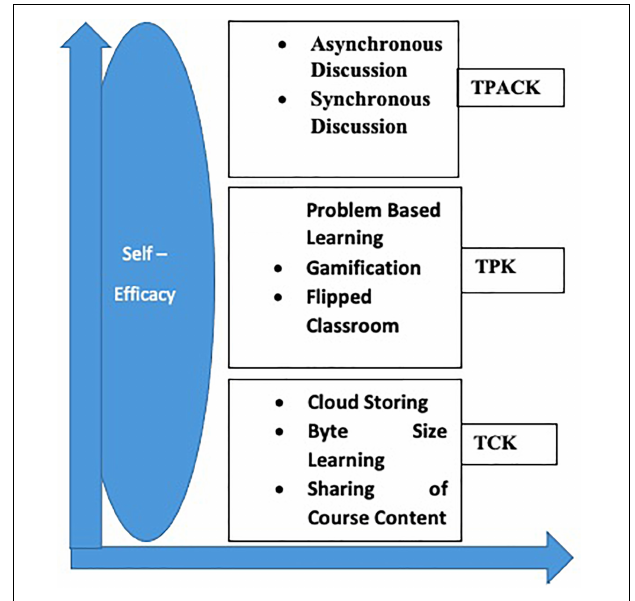
FIGURE 1 | Online teaching experience after a year of the